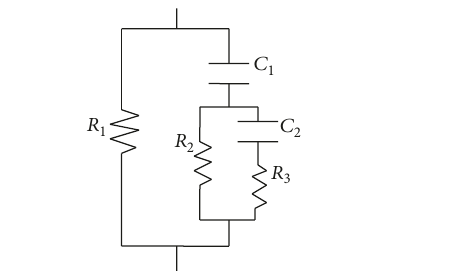
Figure 5: Equivalent circuit model proposed by Zhang et al.